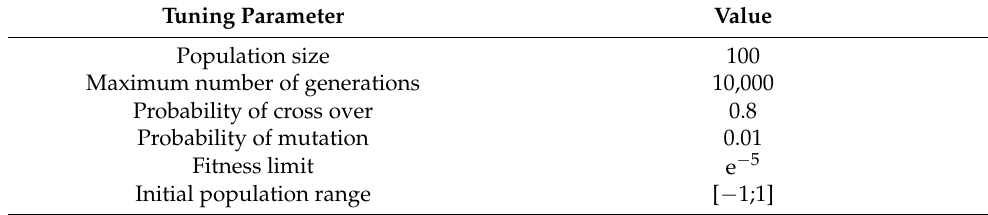
Table 3. Tuning parameter of